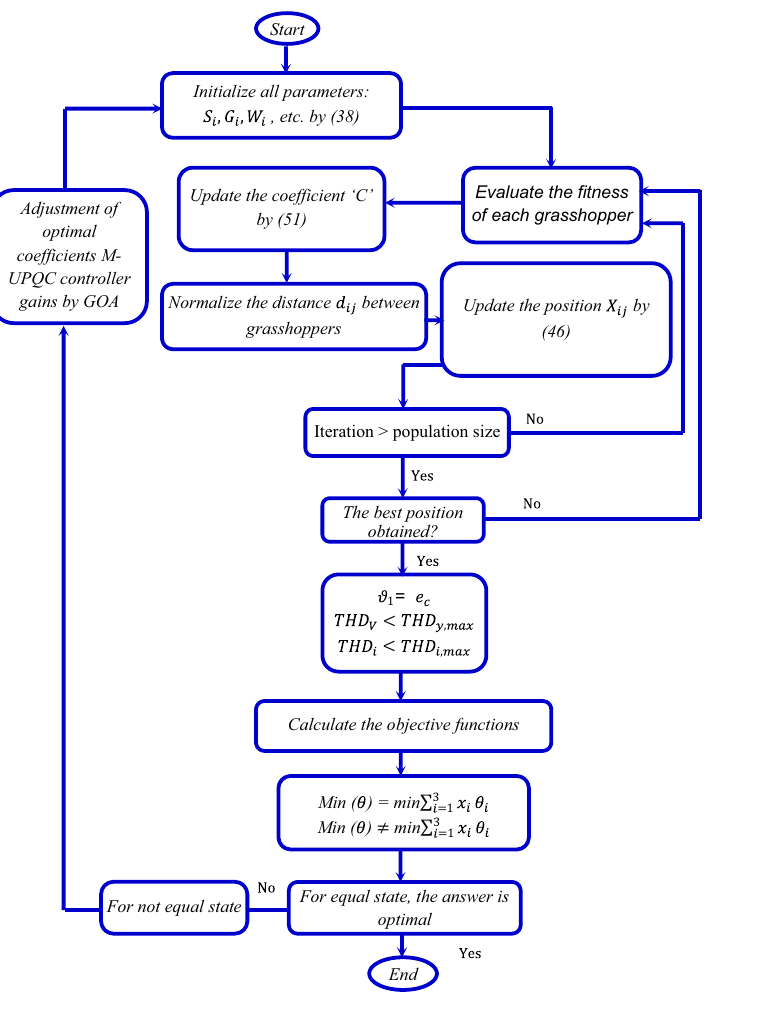
Figure 9. Flowchart of the proposed technique based on GOA